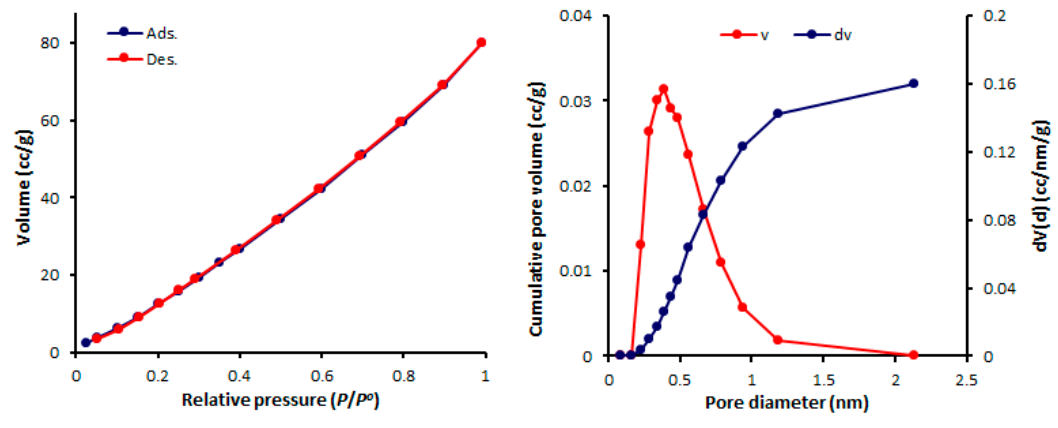
Figure 7. N 2 isotherms and pore diameters of 4 .